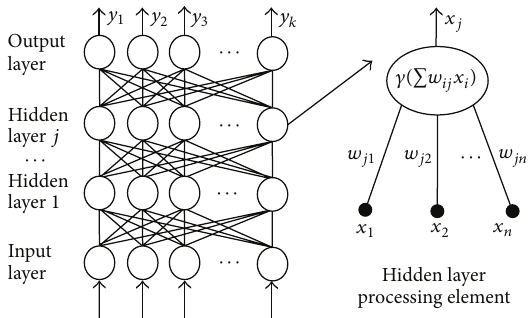
Figure 2: General schematic of a neural network